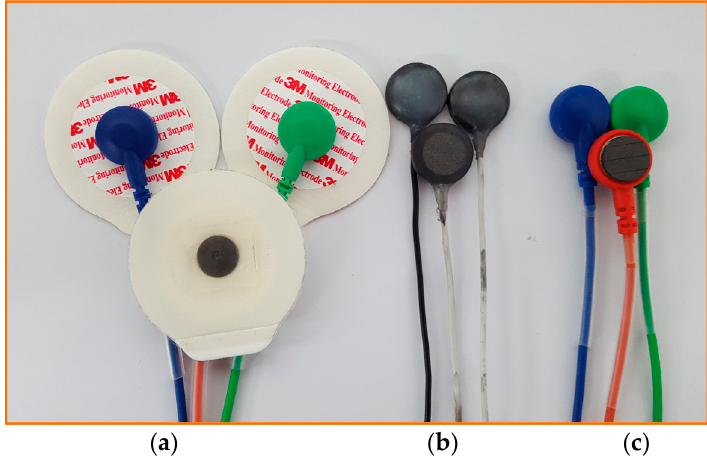
Figure 4. Three types of electrodes being used to perform the experiment: ( a ) commercial Ag/AgCl electrodes; ( b ) pencil lead powder-type electrodes; and ( c ) pencil lead solid-type electrodes.